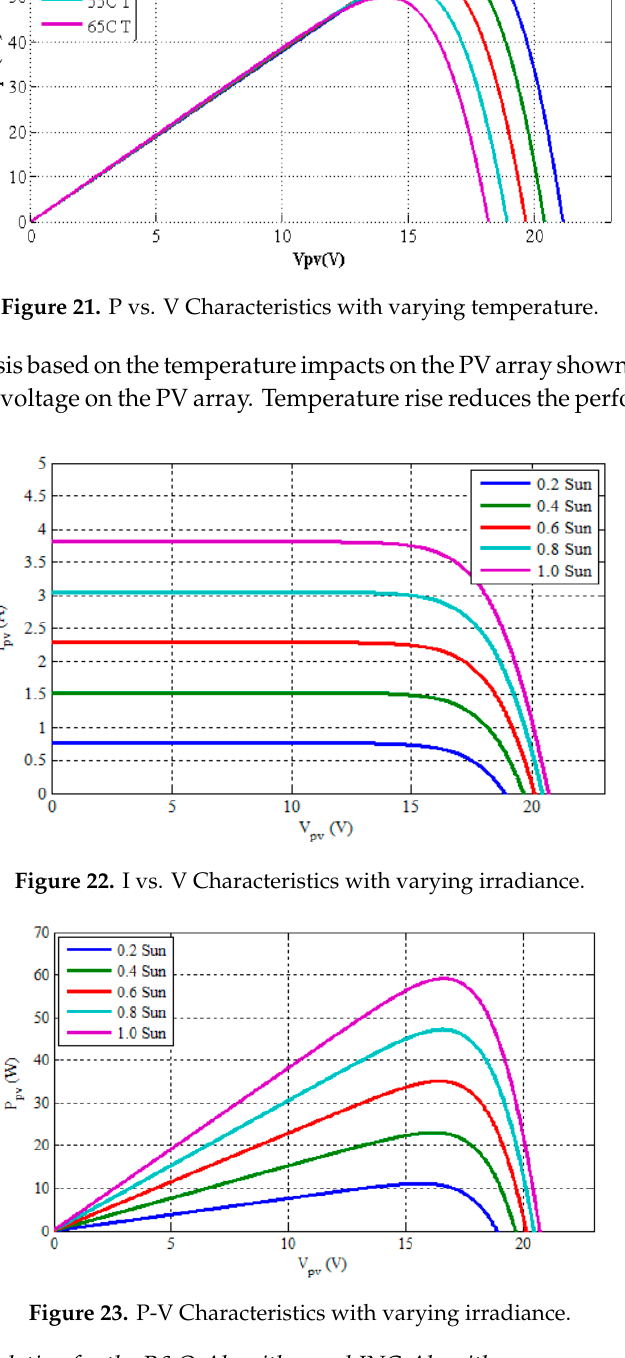
Figure 20. I vs. V Characteristics for varying temperature.